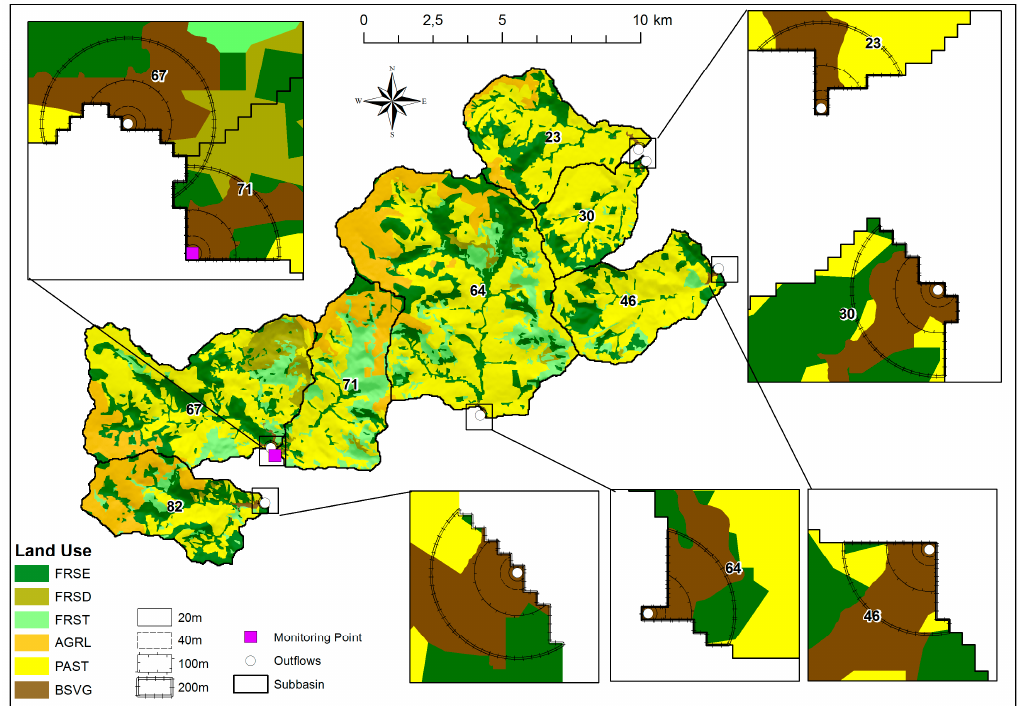
Figure 5. Indication of buffer strip implementation at the sub ‐ basin outflows into the reservoir.